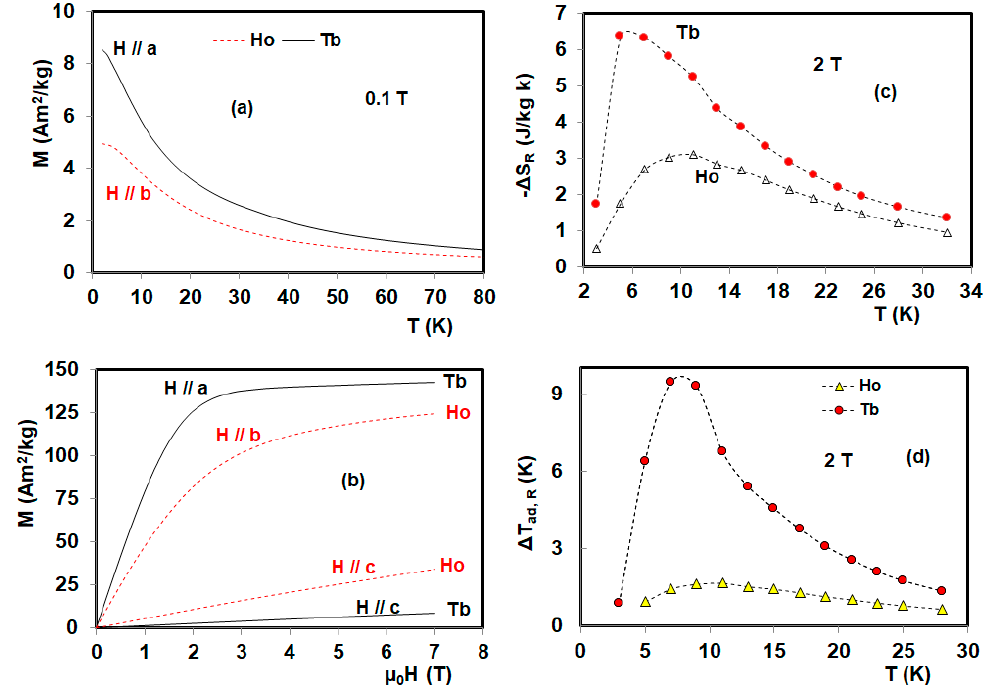
Figure 3. ( a ) Temperature dependence of magnetization under a magnetic field of 0.1 T applied along the easy-axes for TbMn 2 O 5 and HoMn 2 O 5 . ( b ) Isothermal magnetization curves of RMn 2 O 5 (R = Ho, Tb) measured at 2 K under magnetic fields applied along their easy and hard-axes. ( c ) Temperature dependence of the rotating isothermal entropy change in RMn 2 O 5 (R = Ho, Tb) under 2 T. ( d ) Associated adiabatic temperature change under 2 T.